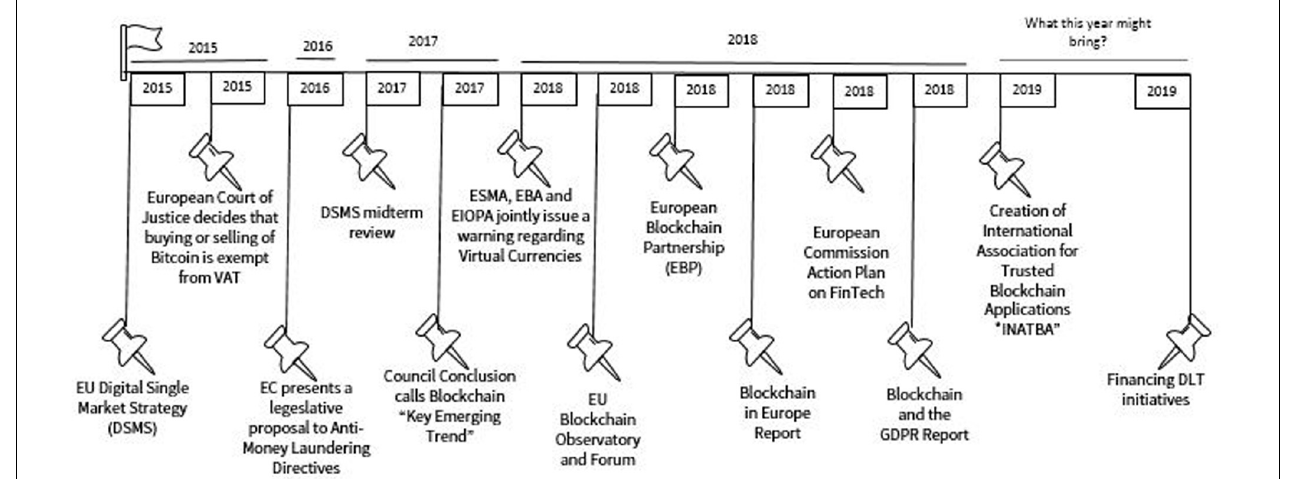
FIGURE 2 | Timeline of EU initiatives related to DLT